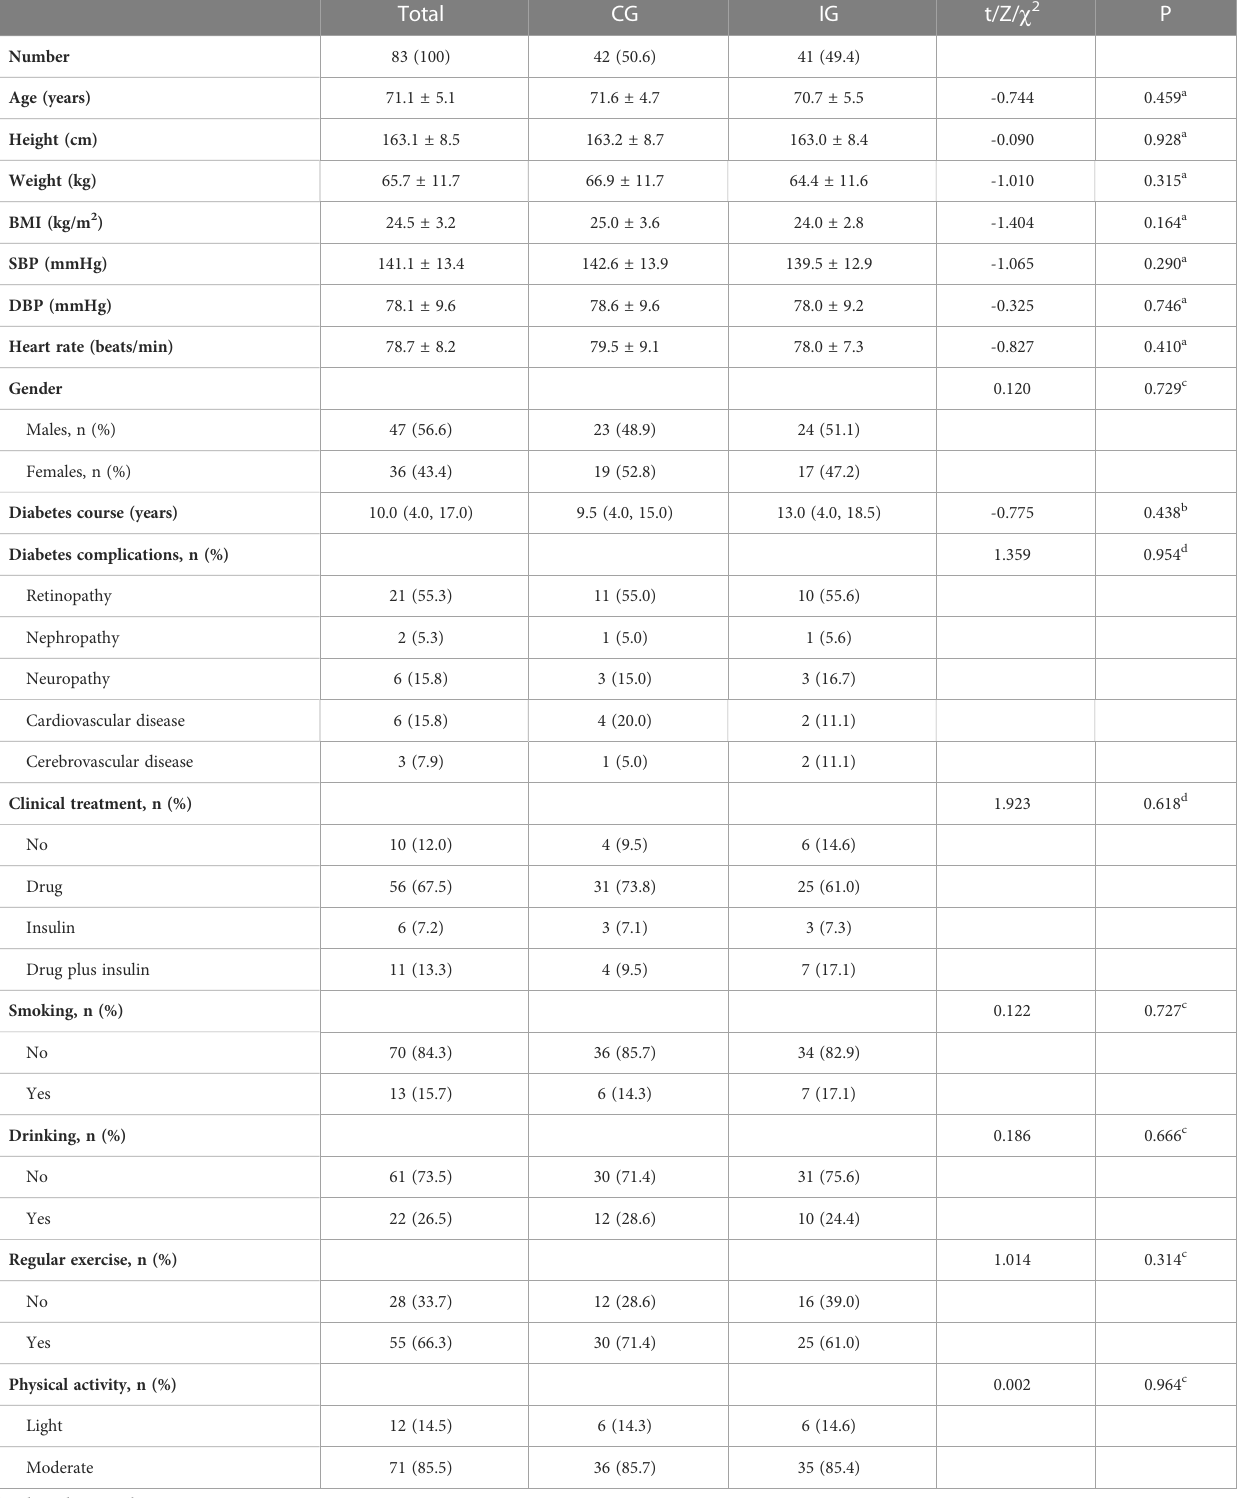
TABLE 1 Basic Characteristics of Participants, (mean ± SD) or n